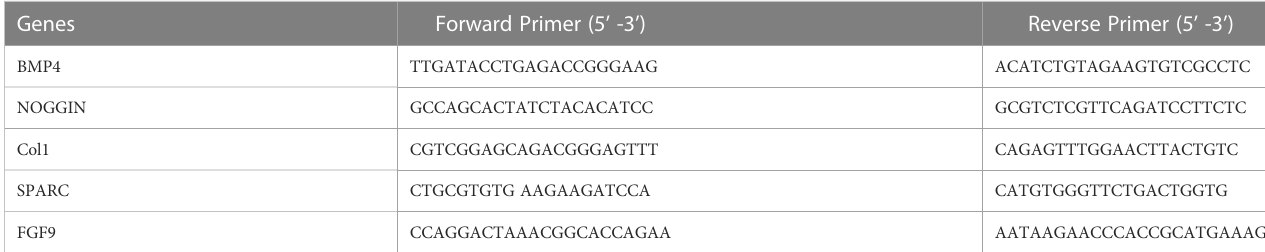
TABLE 1 Primer sequences used for real-time PCR.